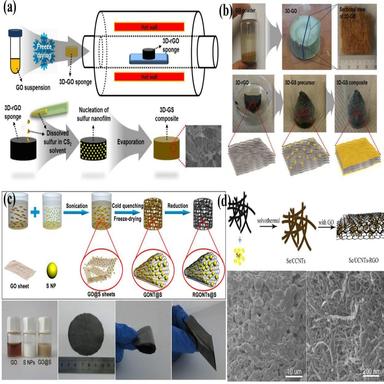
(a) The schematic synthesis procedure of 3D structured sulfur-rGO sponge (3D-GS) composite and unique nano-granules assembled 3D-GS composite prepared by a facile low temperature solution method using carbon disulfide (CS2) as solvent as well as the optical observations at each stage of 3D-GS synthesis Copyright 2016, American Chemical Society; (b) FESEM images, TEM and high-resolution TEM images, Se elemental mapping results of the NCS/Se-50 composites Copyright 2015, Royal So